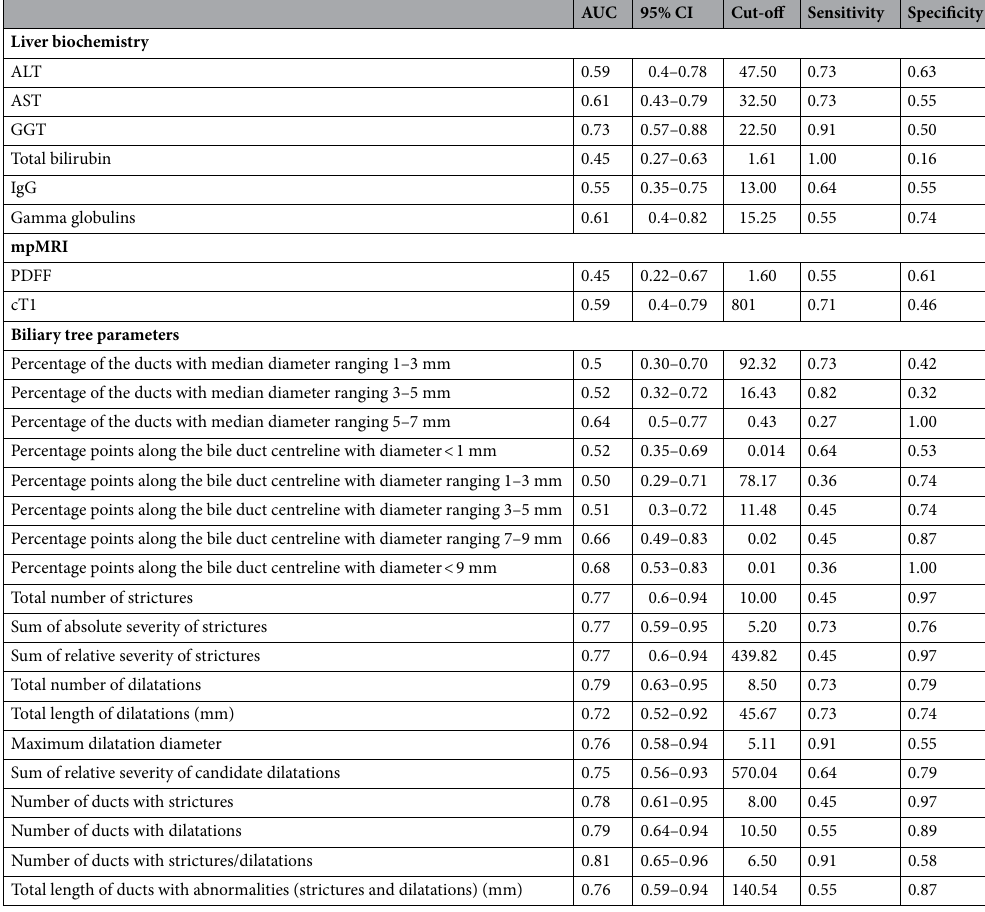
Table 3. Assessment of the diagnostic performance of clinical and imaging parameters for discriminating ASC from AIH using receiver operating characteristic (ROC) curve